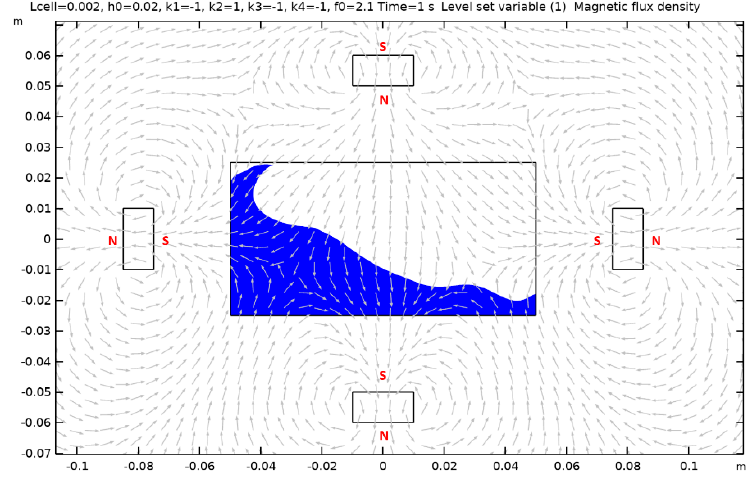
Figure A3. Case 4.